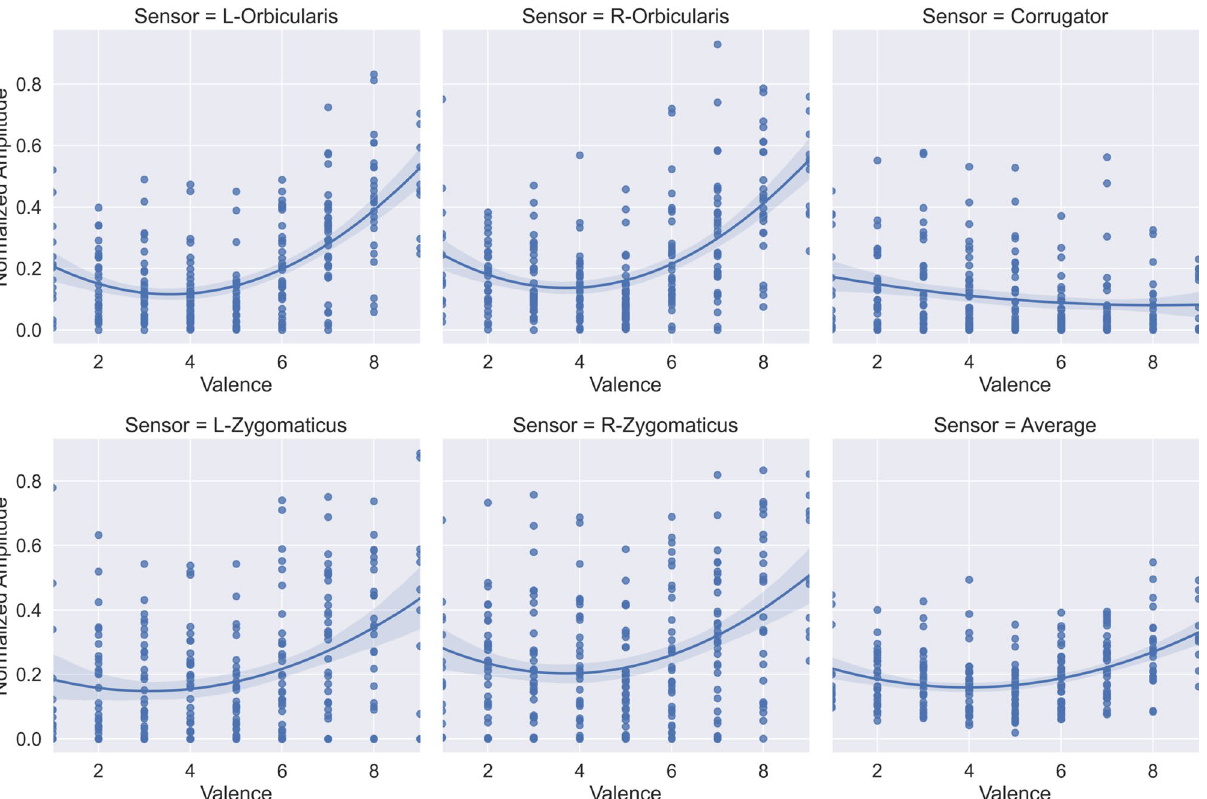
Figure 8. V-shaped relation between the subjective valence ratings (y-axis) and sEMG amplitudes (x-axis). Each scatterplot corresponds to one sensor (left/right orbicularis, corrugator, left/right zygomaticus, and the average of the five